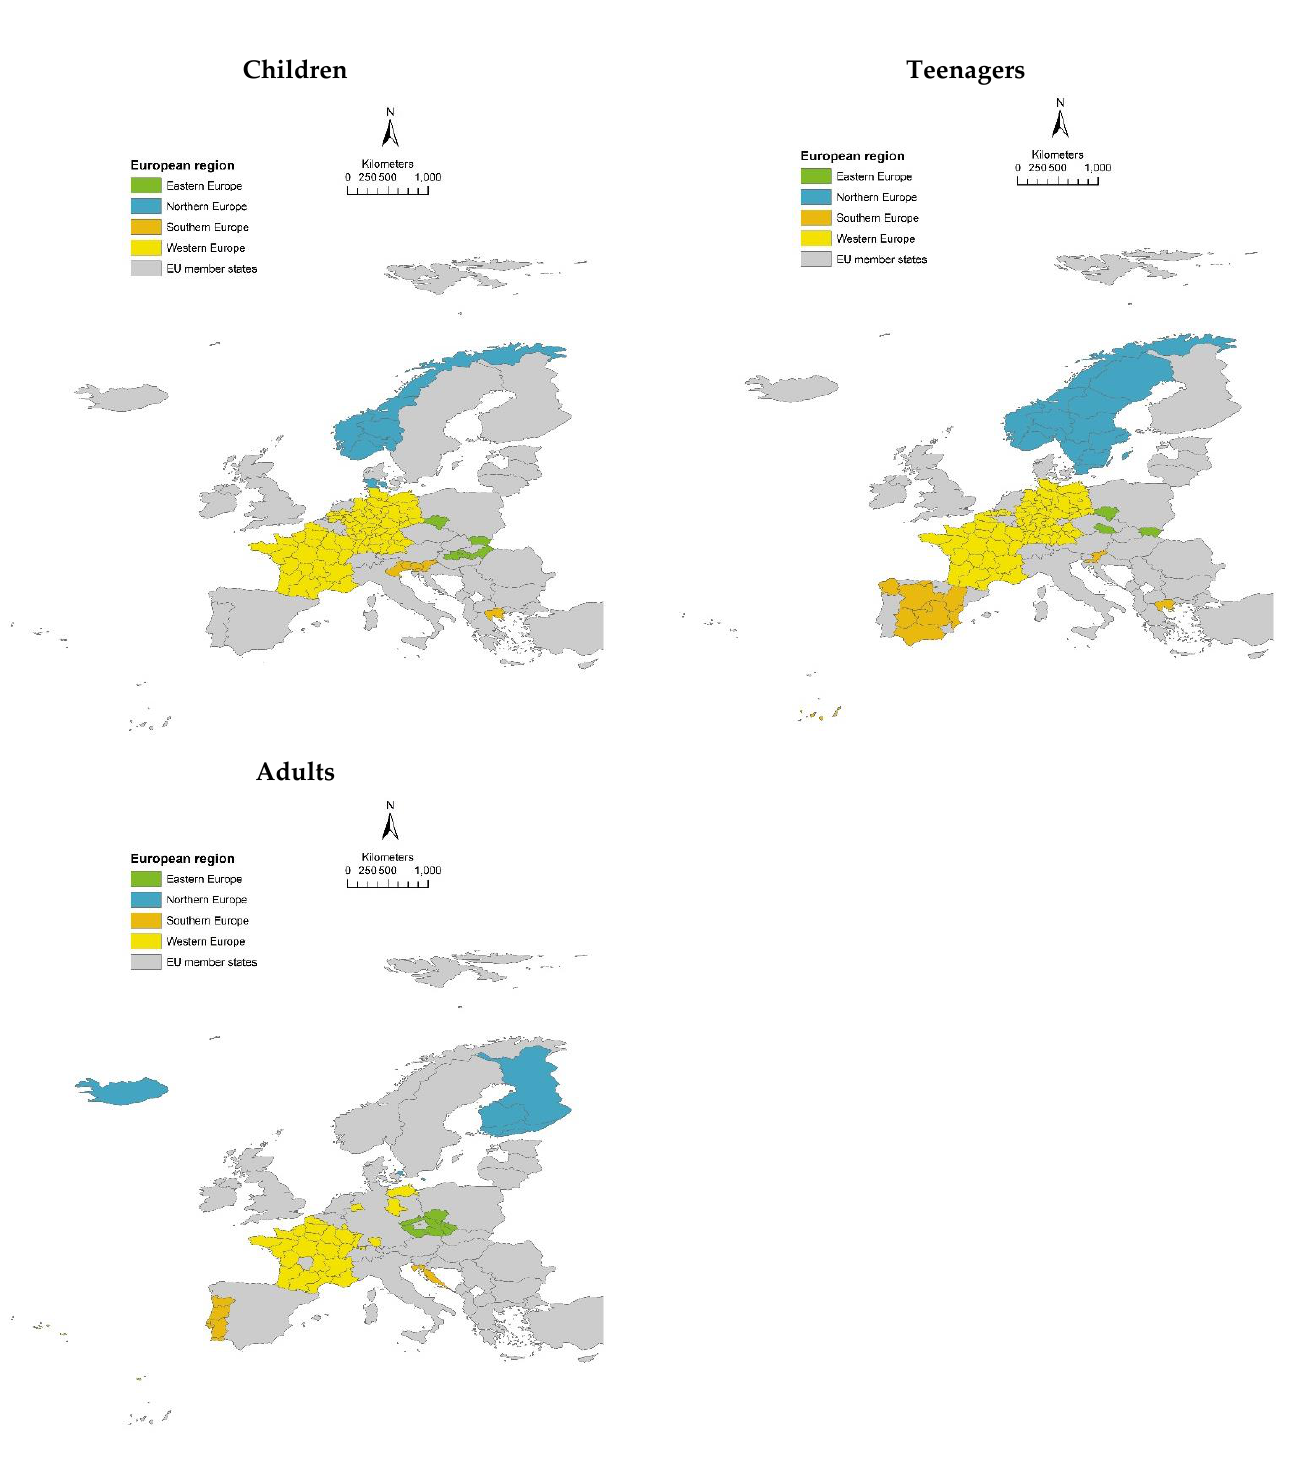
Figure 1. Geographical distribution of children, teenagers and adults’ study populations based on NUTS 2 classification. NUTS = nomenclature of territorial units for statistics developed by EUROSTAT [45] . Upper left = children, upper right = teenagers, bottom left = adults.